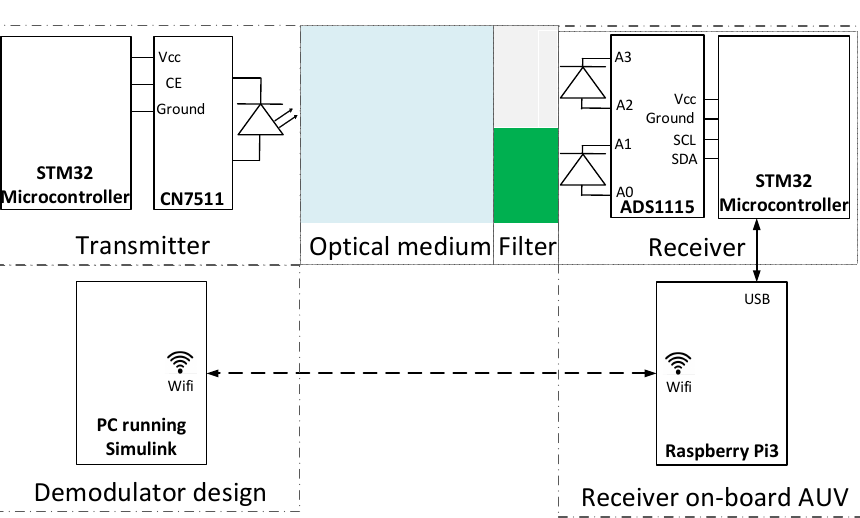
Figure 2. Illustration of transmitter receiver hardware.